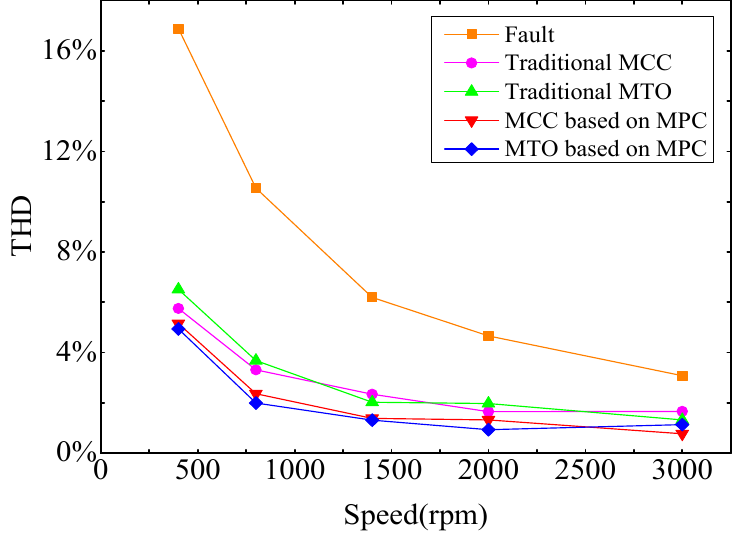
Figure 9. THD of motor speed.